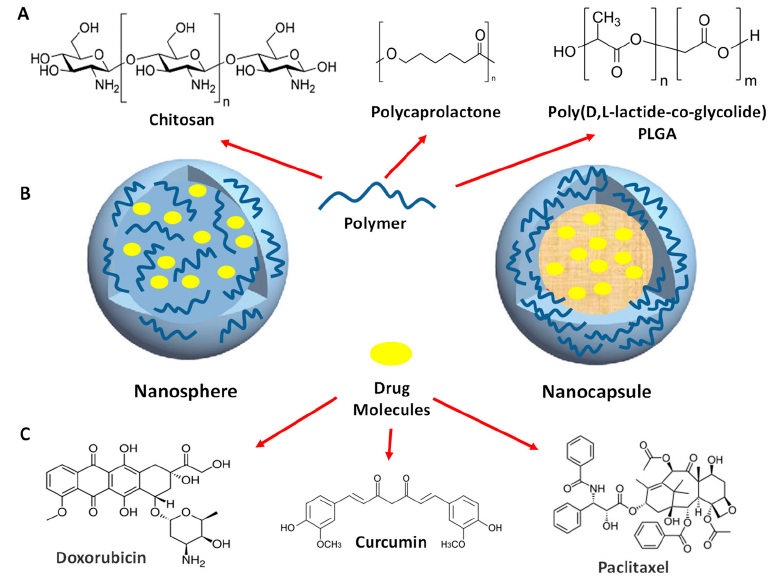
Figure 8. Example of some of the main polymer building blocks ( A ) employed for the formation